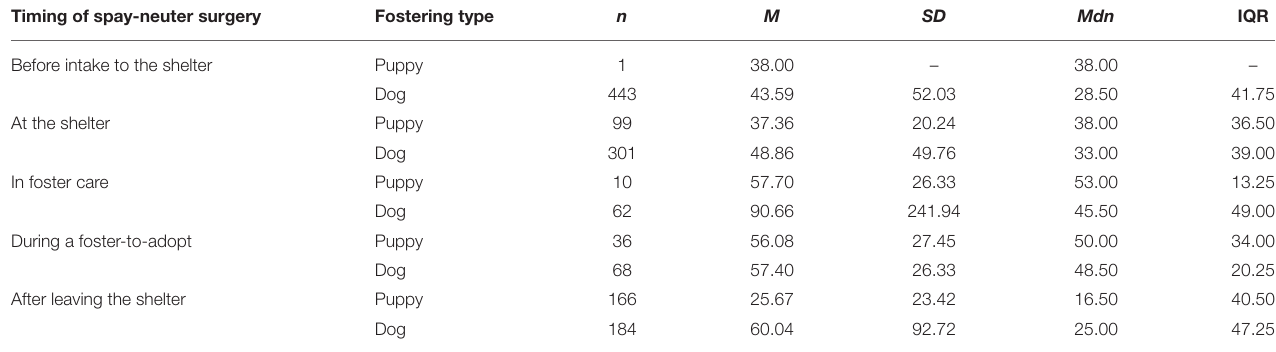
TABLE 7 | Length of stay (in days) by timing of spay-neuter surgery and fostering type. Timing of spay-neuter surgery